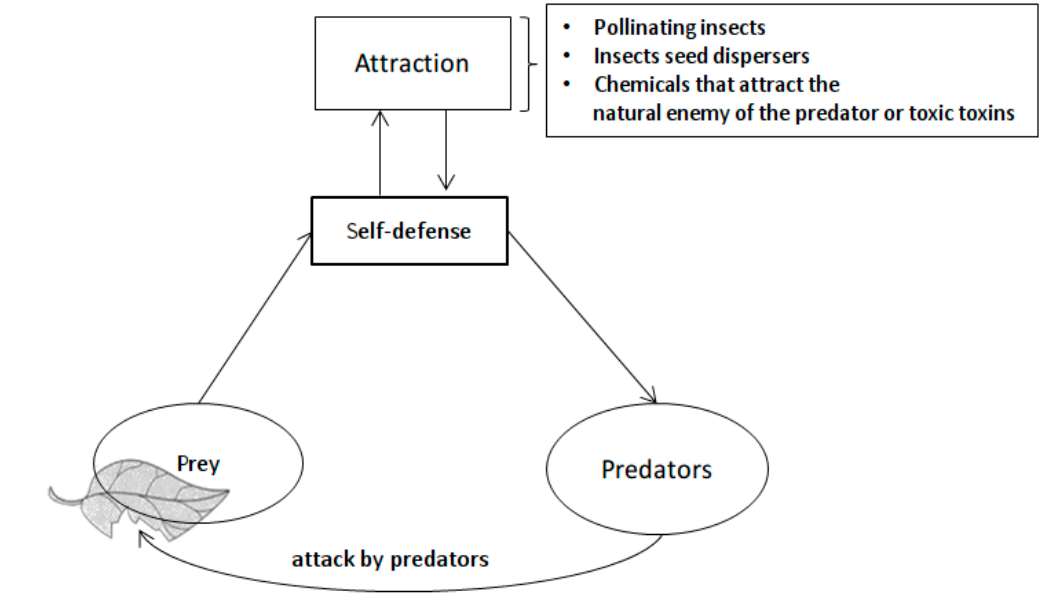
Figure 1. Graphic representation of self-defense techniques.